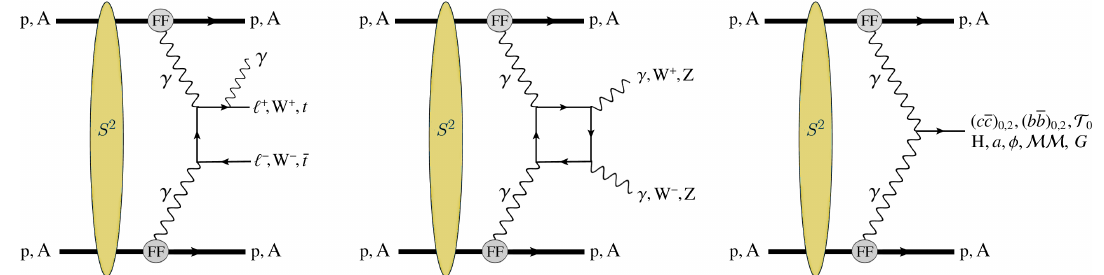
Figure 1 . Typical exclusive (cid:13)(cid:13) collision processes in UPCs of proton and ions (with form factors FF and survival probabilities S 2 ) that can be automatically generated with the gamma-UPC code: t -channel charged particle pair production with final-state photon radiation (left), box diagrams for diboson production (center), and resonant production of SM and BSM spin-even states (right).